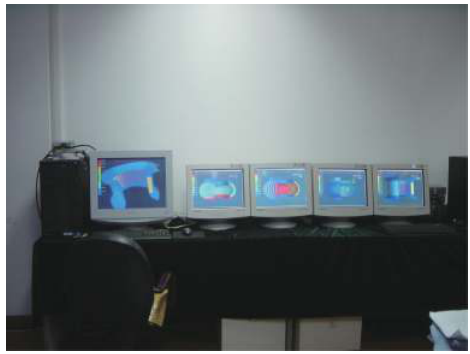
Fig. 4 Multiviewport visualization